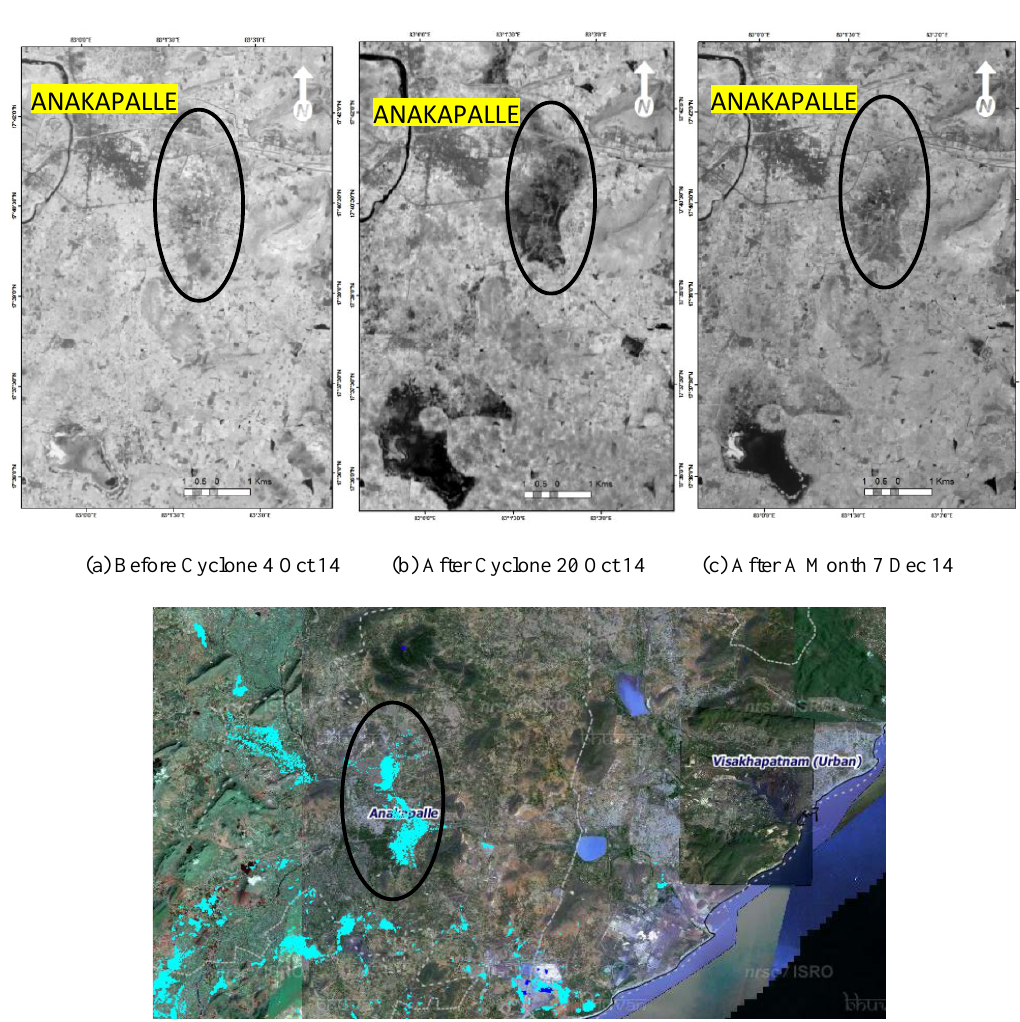
Figure 9. Anakapalle Inundation